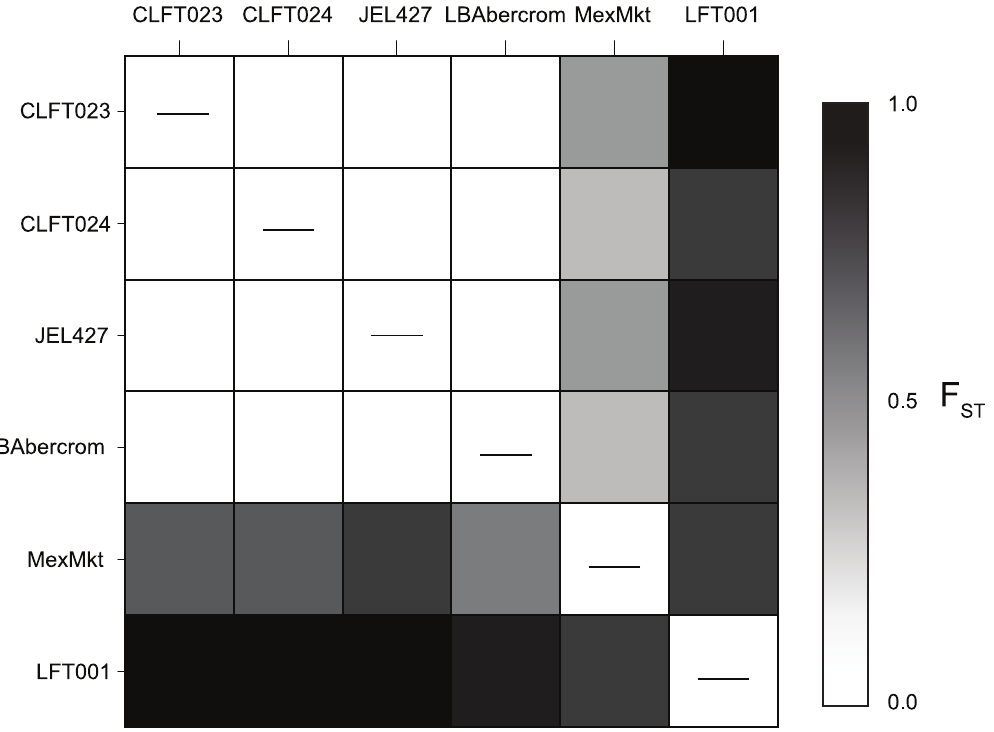
Figure 6. Pairwise F ST values based on ITS1 haplotype frequencies in each Bd strain. Upper and lower diagonals are pairwise F ST values estimated from ITS1 haplotypes obtained by cloning/Sanger sequencing, and from Illumina sequencing, respectively. Darker shades represent greater genetic differentiation.